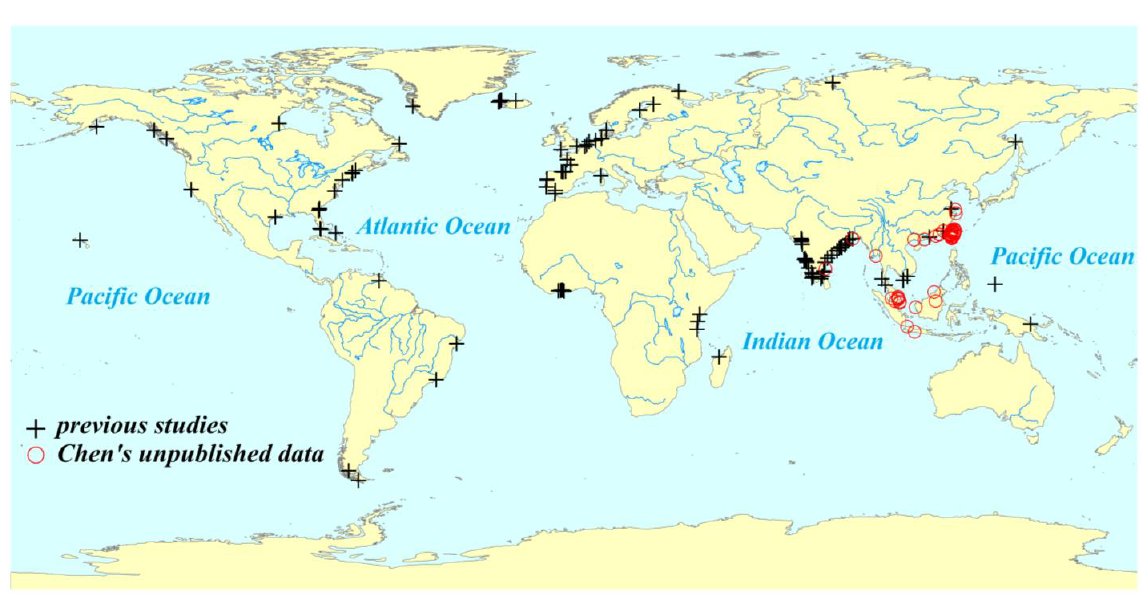
Fig. 1. Distribution of estuaries studied. 2